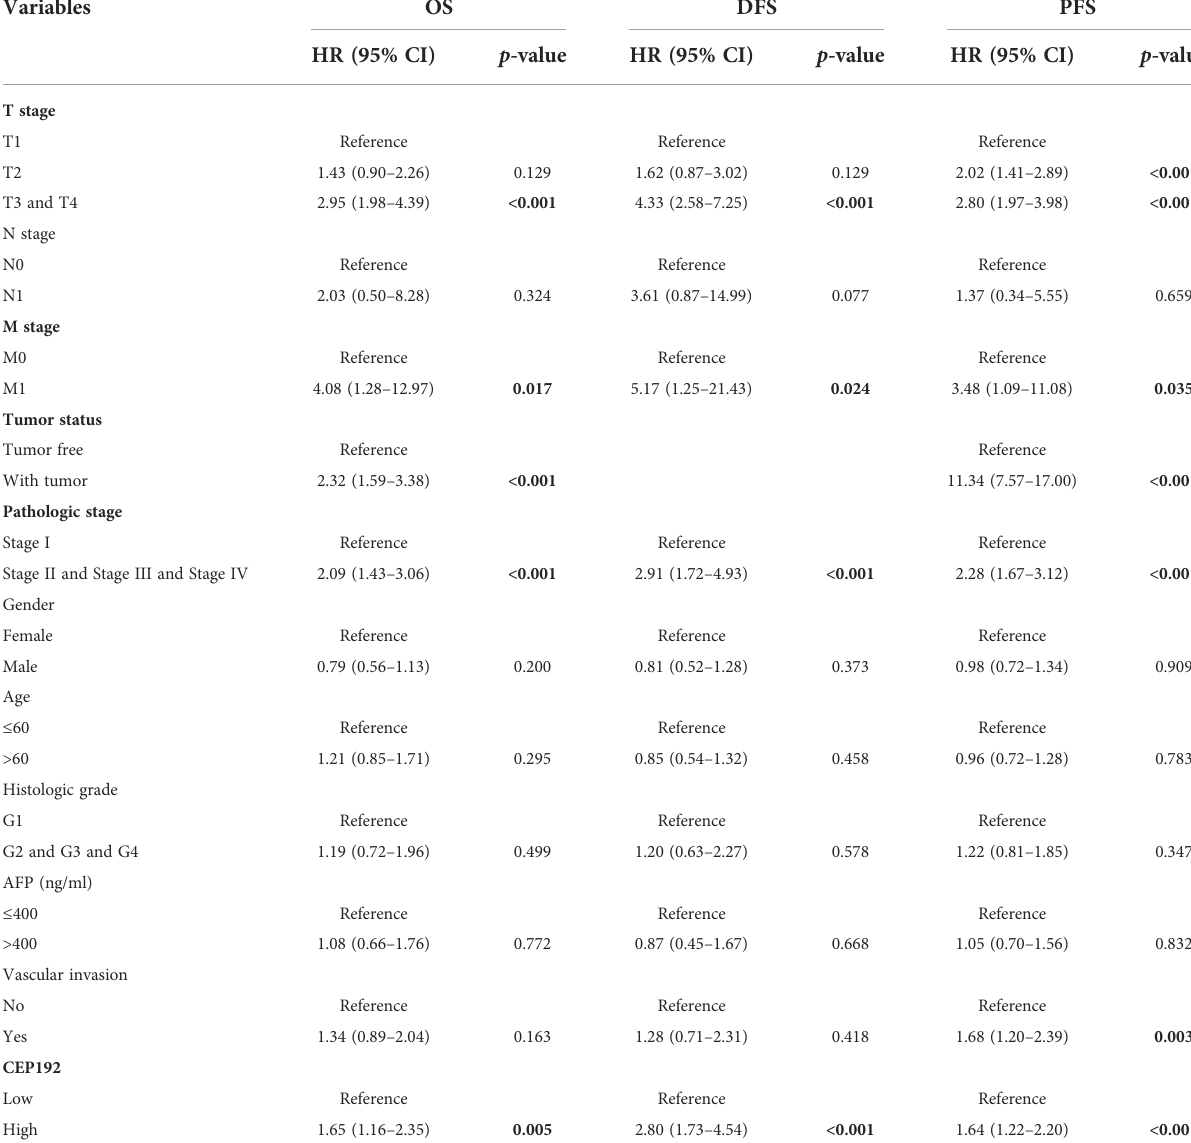
TABLE 2 Univariate Cox proportional hazard models for overall survival (OS), disease-free survival (DFS), and progression-free survival (PFS) in HCC patients.